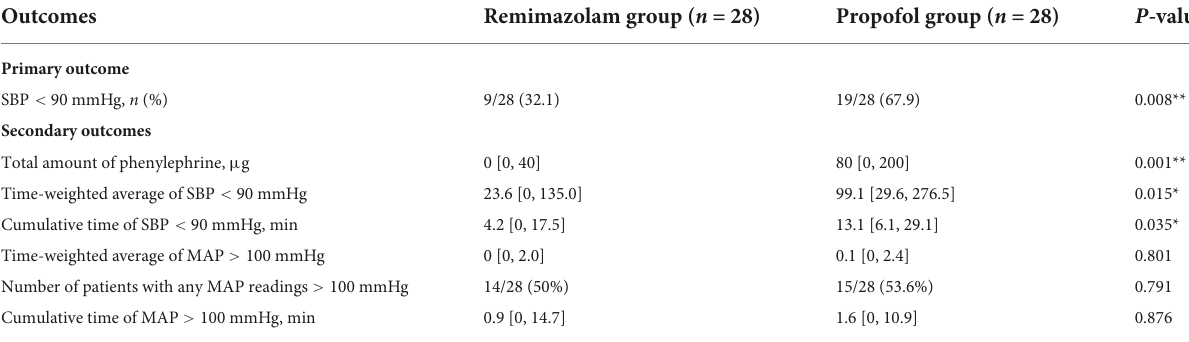
TABLE 2 Summary of blood pressure